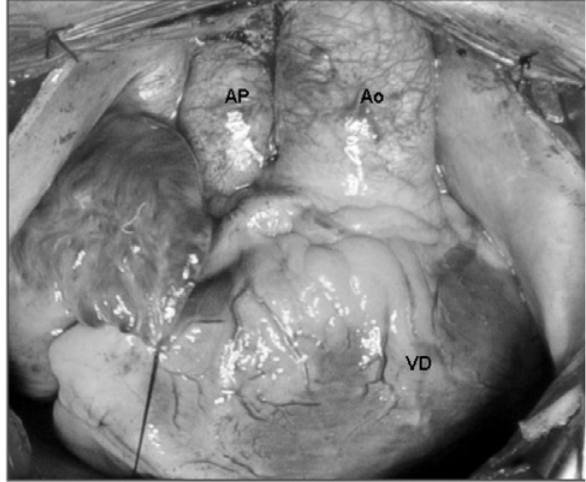
Fig. 1 - Fotografia cirúrgica. Observam-se estruturas cardíacas, após abertura do pericárdio. Aorta (Ao) em posição anterior, originando-se do ventrículo direito (VD) e artéria pulmonar (AP), em posição posterior e à direita da Ao